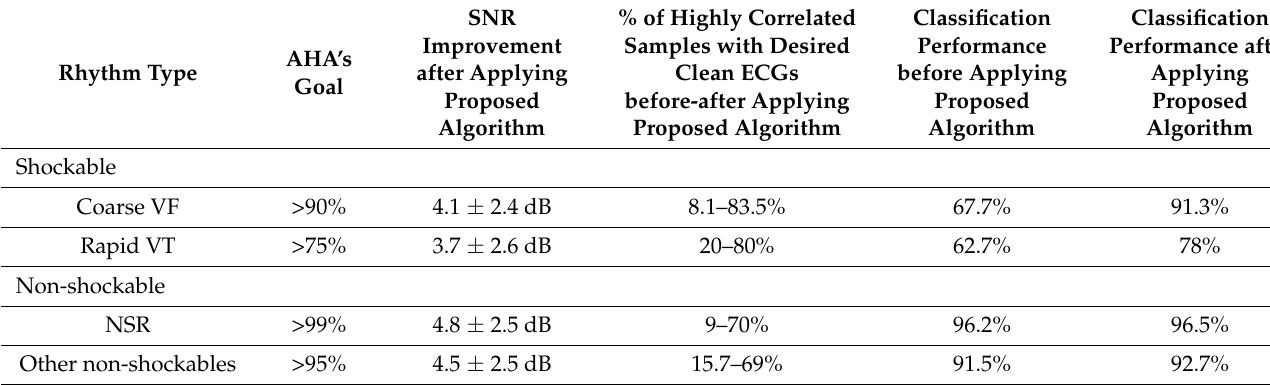
Table 4. Results of the proposed filtering algorithm on the validation set.